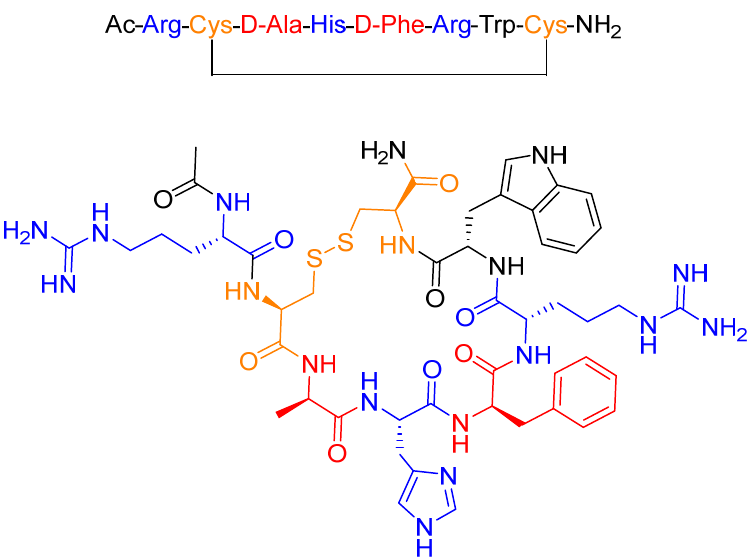
Figure 4. Chemical structure of setmelanotide (Imcivree TM ).